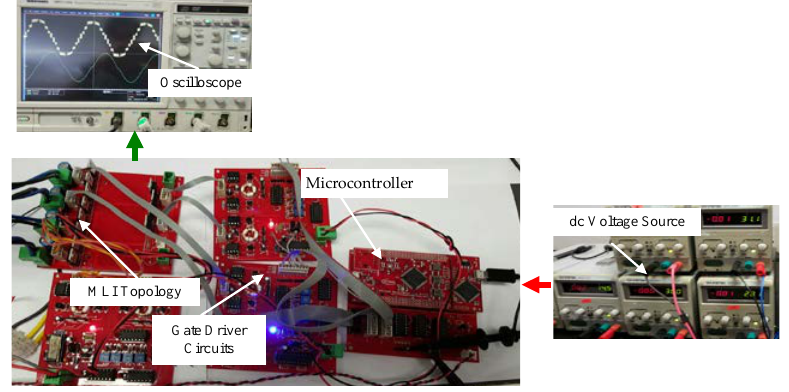
Figure 12. The photograph of the prototype MLI circuit.